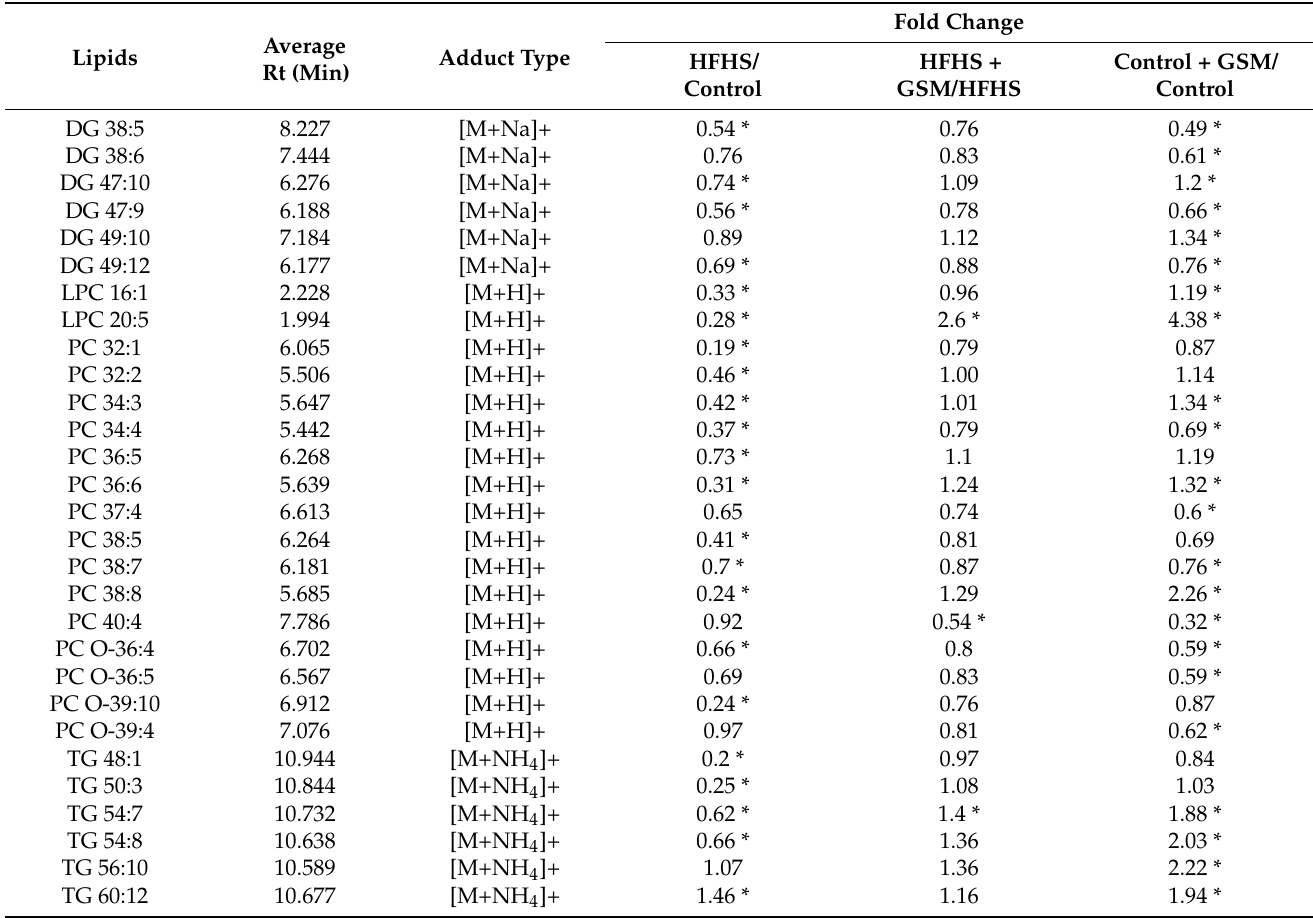
Lipids were determined using the VIP value > 1 and FDR < 0.05 from the OPLS-DA model. Fold change was calculated by dividing the mean of the peak intensity of each lipid from each of the two groups. * Lipids showing significant differences ( p -value < 0.05) between groups as determined by Student’s t